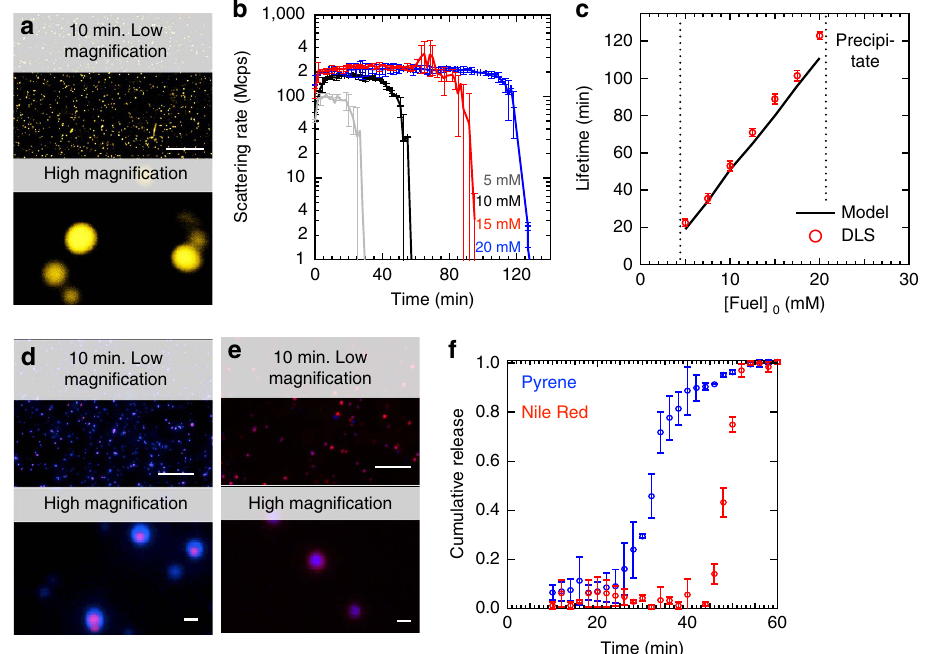
Figure 4 | Transient colloids formed by Fmoc-E. ( a ) Confocal micrographs of 10mM Fmoc-E with 10mM EDC after 10min shows the formation of colloids in the presence of 2.5 m M Nile. The scale bars represent 25 m m and 1 m m for the lower and higher magnification, respectively. ( b ) DLS scattering intensity against time for 10mM Fmoc-E with varying concentration of fuel. ( c ) The lifetimes of the colloids as a function of concentration of initial fuel as determined by DLS and the kinetic model. The two dotted lines indicate the window where particles were found. ( d ) Micrographs of 10mM Fmoc-E with 10mM EDC after 10min that were prepared in the presence of 250nM Nile Red while 2.5 m M pyrene was added after 5min. The red (Nile Red) and blue (pyrene) channels were overlaid. Scale bar, 25 (lower magnification); 1 m m (higher magnification). ( e ) Micrographs of 10mM Fmoc-E with 10mM EDC after 10min that were prepared in the presence of 250nM pyrene while 2.5 m M Nile Red was added after 5min. The red (Nile Red) and blue (pyrene) channels were overlaid. The scale bars represent 25 m m and 1 m m for the lower and higher magnification, respectively. ( f ) Release profiles of pyrene (blue markers) and Nile Red (red markers) of the particle described in d . Data collection was started 10min after addition of EDC. All error bars represent the s.d. ( n ¼